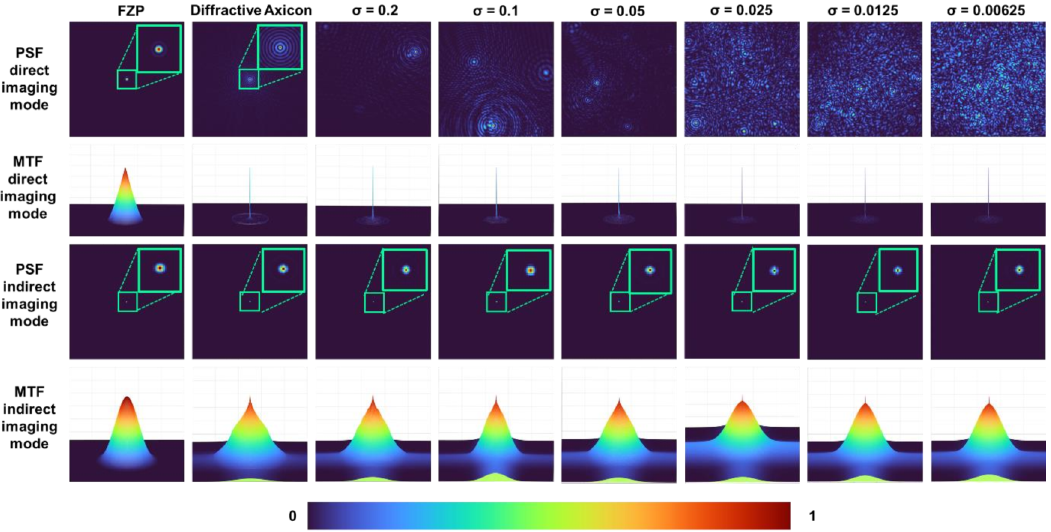
Figure 3. PSF and MTF obtained for direct and indirect imaging modes for FZP, diffractive axicon ( σ = 1), self-interfering Bessel beams σ = 0.2, 0.1, 0.05, 0.025, 0.0125, and 0.00625. The MTFs are normalized to 1.